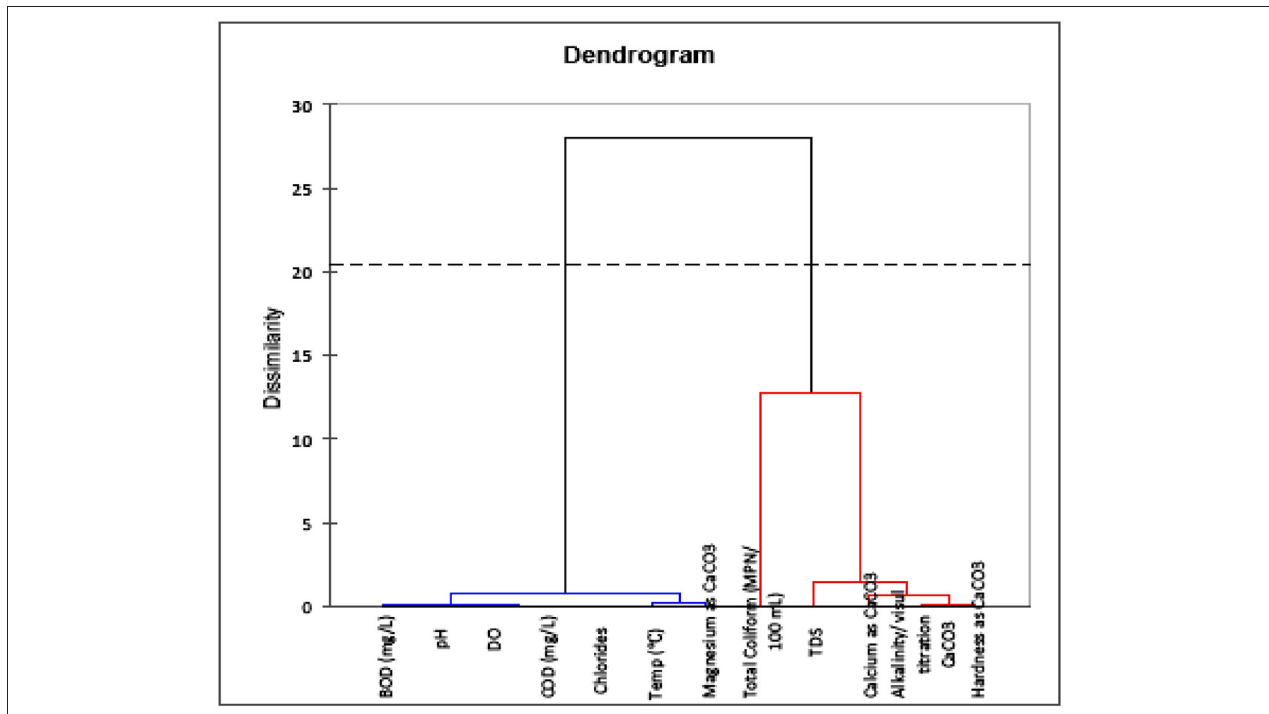
FIGURE 7 | Dendrogram for physicochemical parameters at Dehradun for 2019.